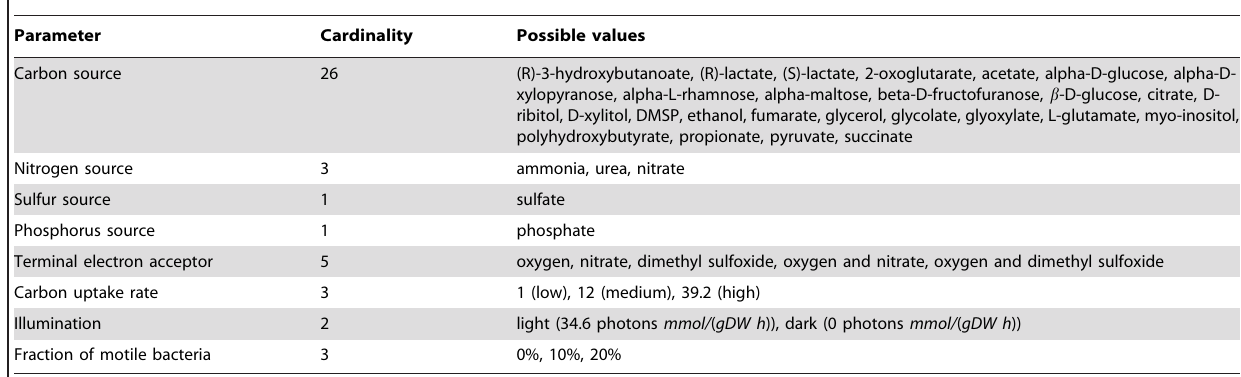
Table 4. Conditions whose combinations were covered in the simulations.